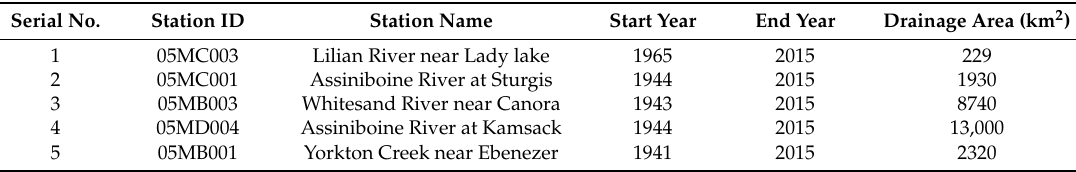
Table 1. Available hydrological stations in the UARB at Kamsack basin utilized during model calibration and validation.